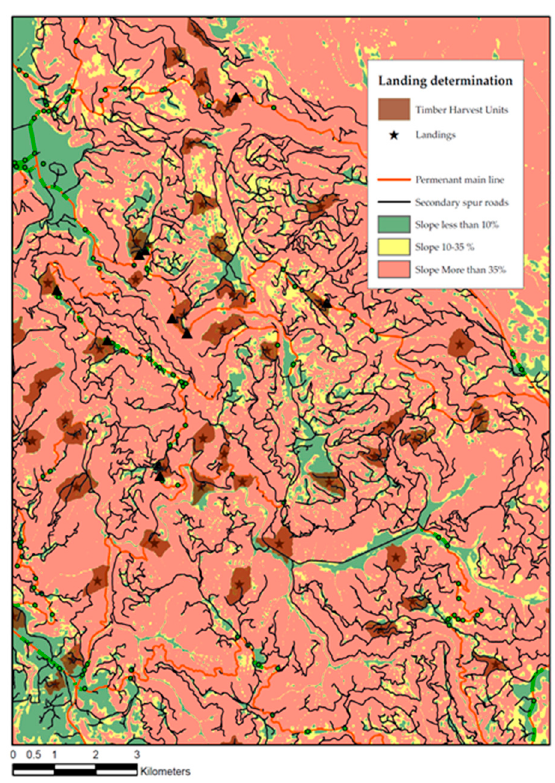
Figure 3 . Centralized biomass recovery operation (CBRO) and biomass conversion technology (BCT) sites were determined through a series of geospatial process, which were then used to locate, calculate, and display the locations of recoverable biomass (per harvest unit and CBRO) and harvesting method. Road distance was used to calculate haul route distance.